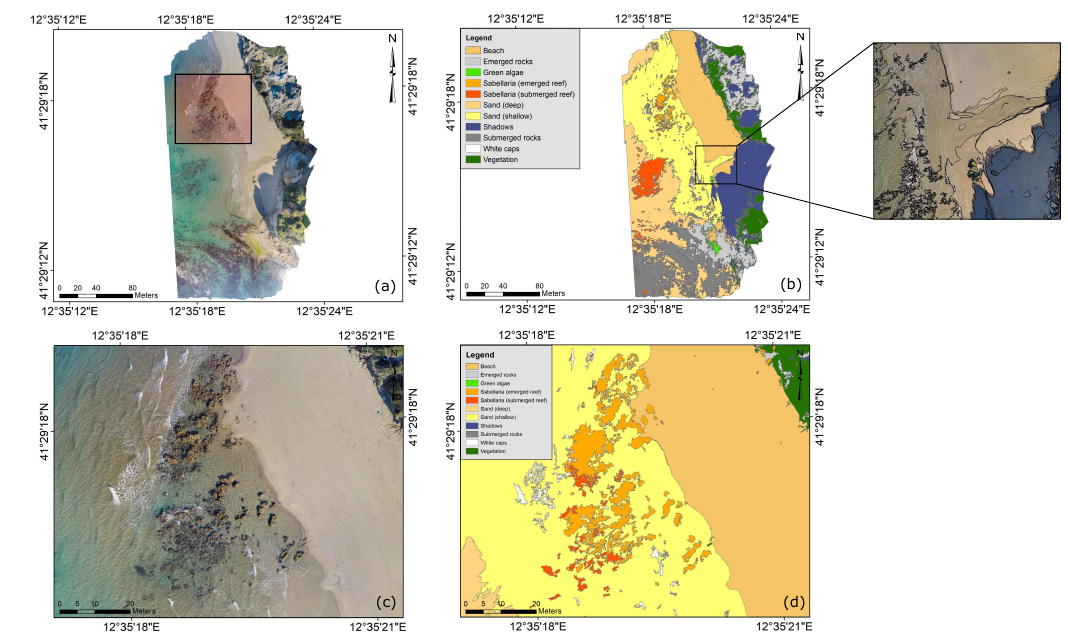
Figure 10. Orthomosaic of the S4 site ( a ) generated through UAV imagery representing a complex sandy/rocky coast with both a submerged and an emerged (highlighted area) reef of Sabellaria alveolata . Raster map produced after segmentation and classification following OBIA routine ( b ). The inset shows the effects of tree shadows during segmentation steps, leading to the misclassification of the emerged beach. Detailed view ( c ) of the emerged reef (1:500) and the same area after image classification performed by the OBIA algorithm ( d